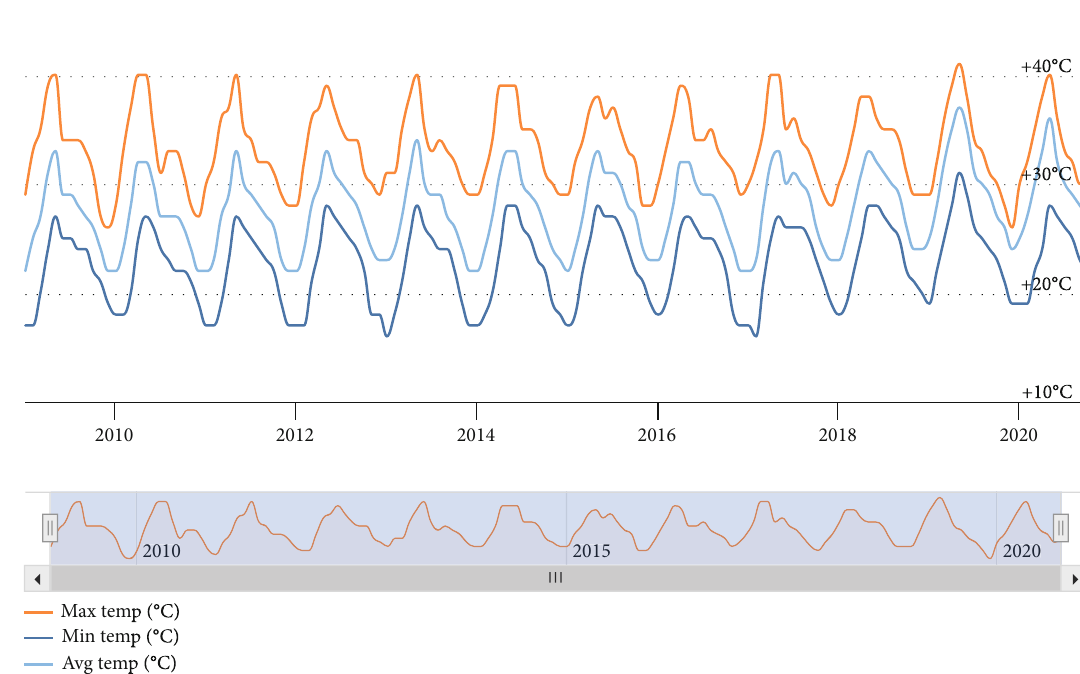
Figure 2: Yearly temperature average of Vellore from 2009 to 2019